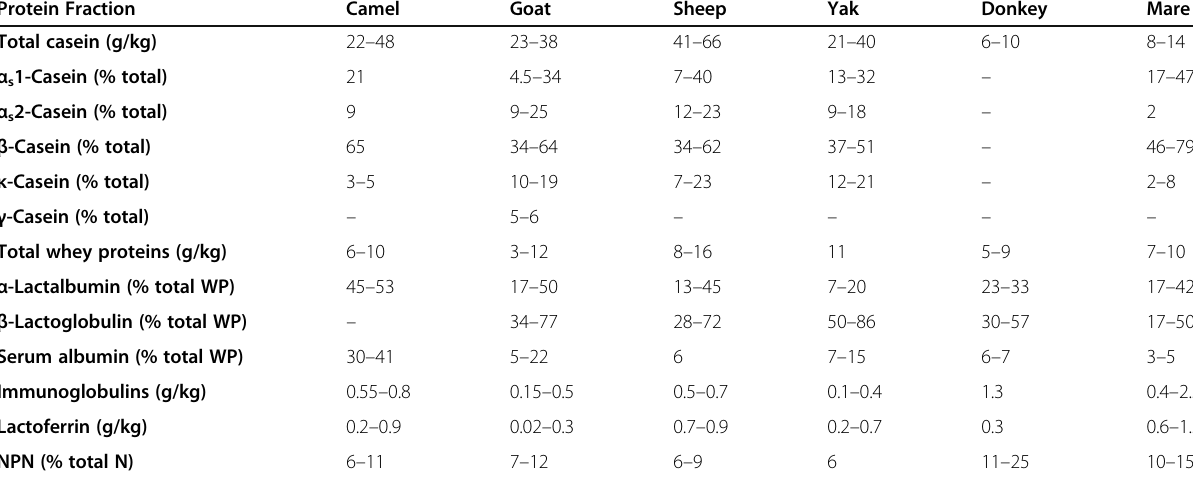
Table 2 Comparative protein composition profile from milk of minor dairy species (concentration range) Protein Fraction Camel Goat Sheep Yak Donkey Mare Total casein